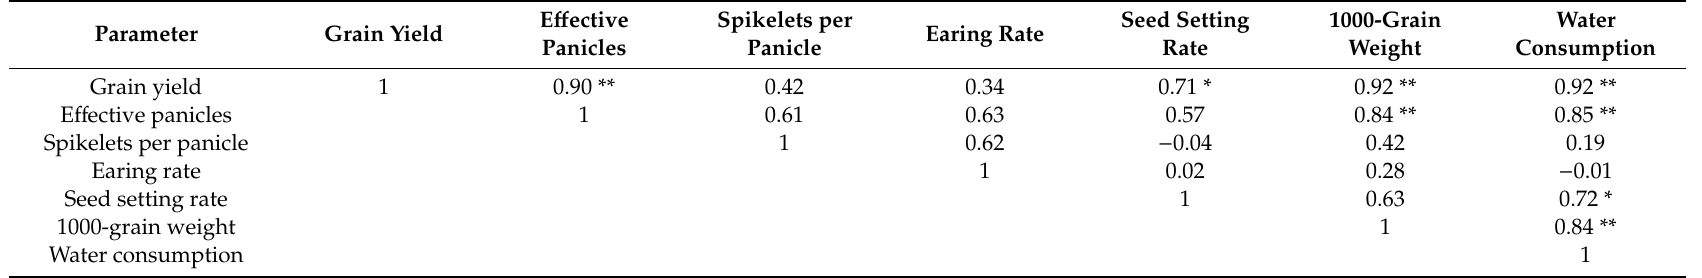
Table 6. Correlation matrix between yield components and water consumption of drip irrigated rice where * indicates significant correlation at p < 0.05 and ** indicates significant correlation at p < 0.01, sample size (N =